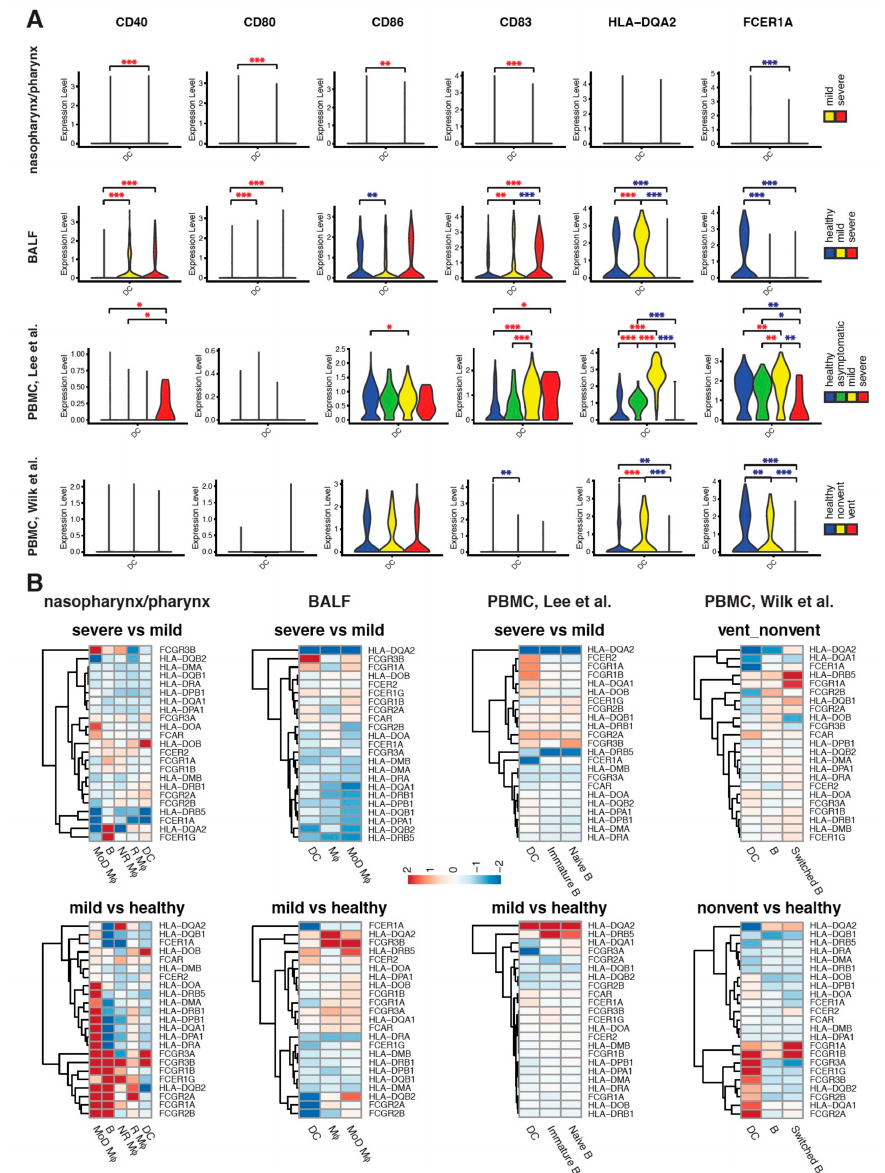
Figure 5. TheexpressionprofilesoffunctionalmarkersinDCsatthreesites. ( A )Theexpressiondisparityof markers of maturation (CD83), T-cell stimulation molecules (CD40, CD80, CD86) and antigen presentation molecules (HLA-DQA2 and FCER1A) in DCs of COVID-19 cases and healthy controls. One upper airway (nasopharynx/pharynx), one lung (BALF) and two blood (PBMC) scRNA-seq datasets were analyzed. The expression of each gene is shown in violin plots. For some of genes which has low detection rate, the violin plot displays a bar. Differential expression was tested in severe cases compared to mild cases, in severe cases compared to healthy controls, in mild cases compared to healthy controls, in severe cases compared to asymptomatic cases, in mild cases compared to asymptomatic cases, and in asymptomatic cases compared to healthy controls. Significance was shown by red * for higher mean value and blue * for lower mean value, with * p < 0.05; ** p < 0.01; *** p < 0.001. Despite interest, we did not compare COVID-19 nasopharynx/pharynx samples to healthy controls due to the limited detection of DCs in healthy samples (N = 1). ( B ) The dysregulation of gene expression of MHCII and FcRs in APCs at three sites with COVID-19. For each gene, the alteration of gene expression in APCs of severe COVID-19 cases compared to mild cases, and that in mild COVID-19 cases compared to healthy controls are visualized in heatmaps. Red indicates upregulation and blue indicates downregulation. The scale corresponds to log 2